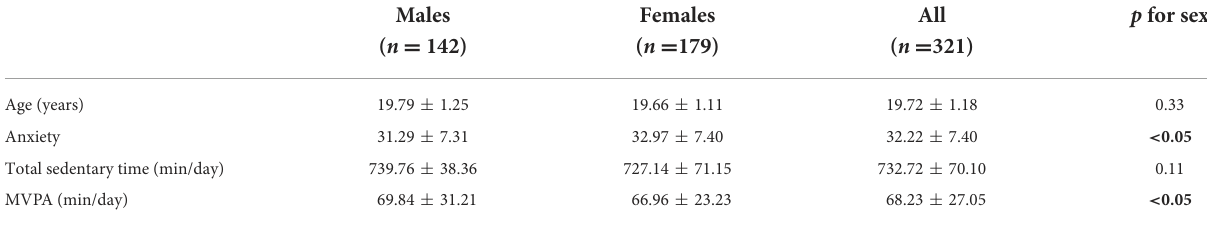
TABLE 1 Characteristics of